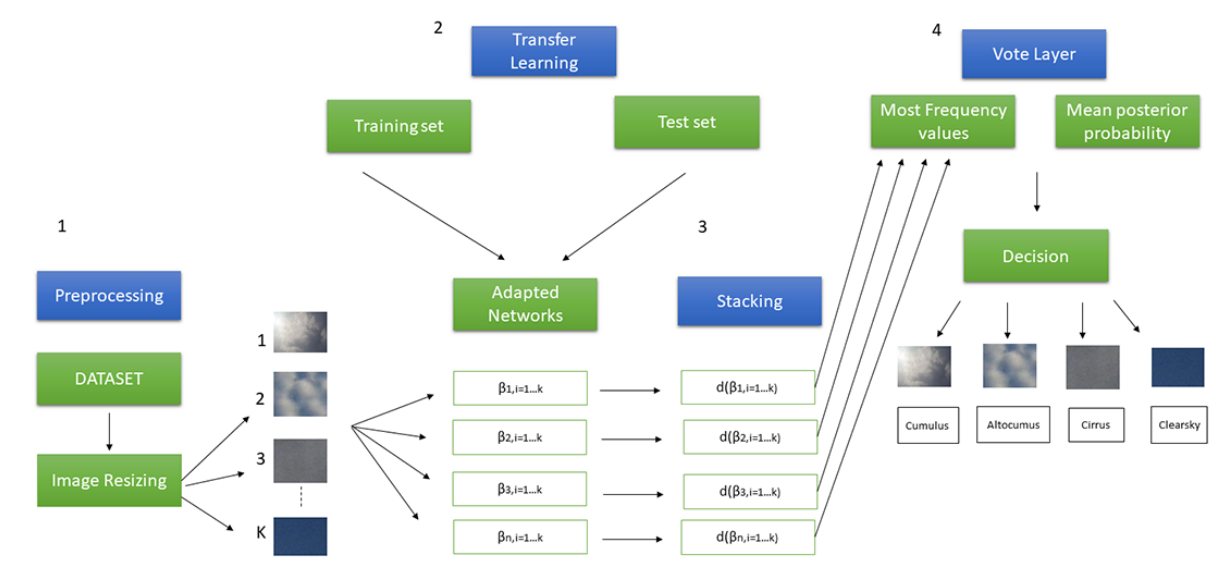
Figure 1. Overview of the proposed framework. The steps of the pipeline are numbered consecutively and the direction of the arrows indicates the data flow. Step 1 indicates image preprocessing described in Section 3.1. Step 2 describes how the different deep neural networks are redesigned and retrained for the classification task as described in the Section 3.2. Steps 3 and 4 illustrate, respectively, the stacking approach adopted to combine the deep neural networks and the vote process for final decision as described in Section 3.3.